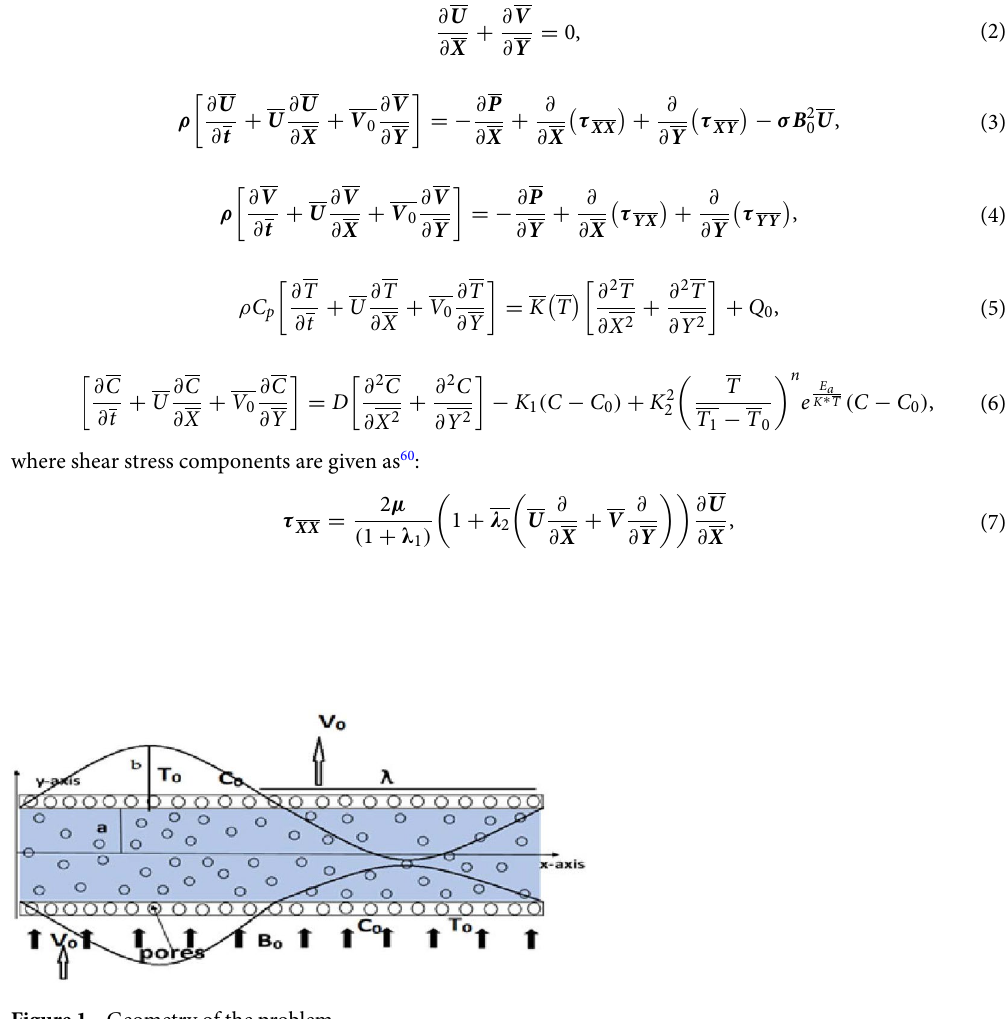
Figure 1. Geometry of the